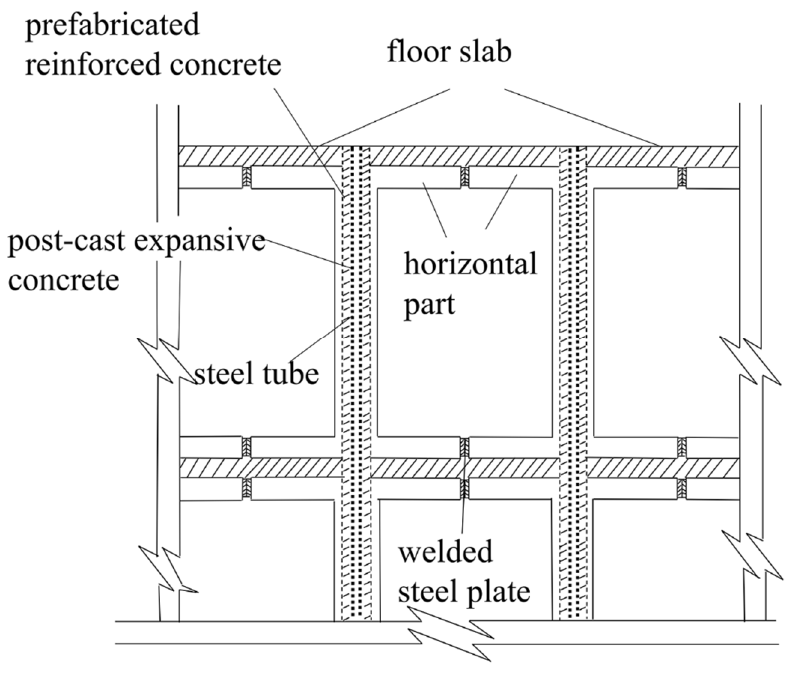
Figure 5. Schematic diagram of the connection between horizontal and vertical load-bearing units.